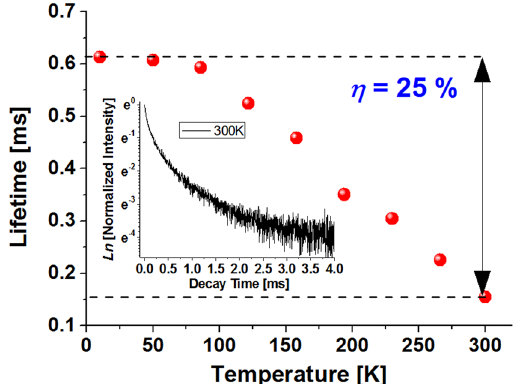
Figure 4. Temperature dependence of the NIR emission lifetime of Ni 2 + doped ZGO GCs. Inset: the decay curve of the NIR emission of Ni 2 + at the room temperature, those measured at other temperatures have a similar profile and thus are not shown.